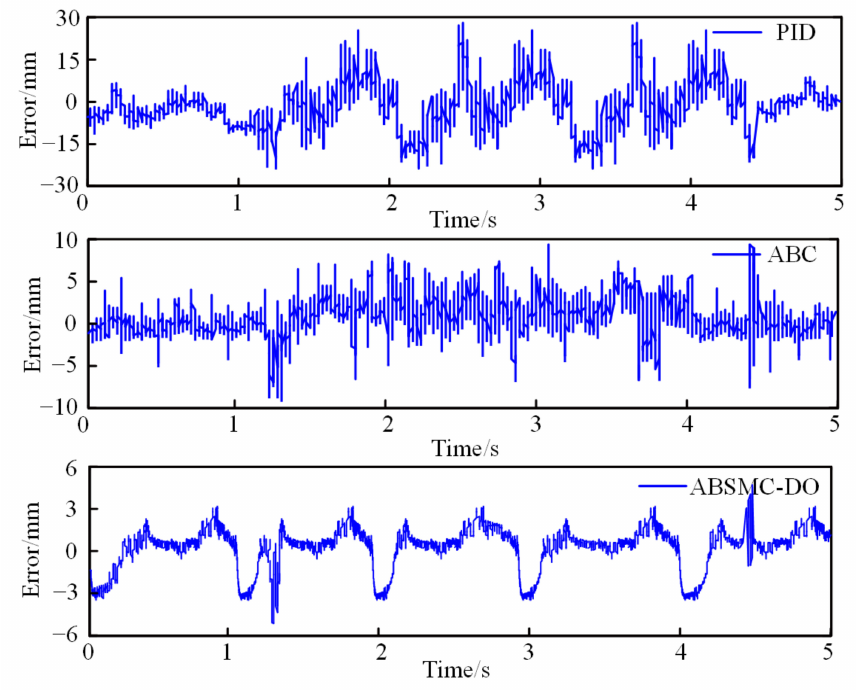
Figure 9. Tracking errors of different controllers with external